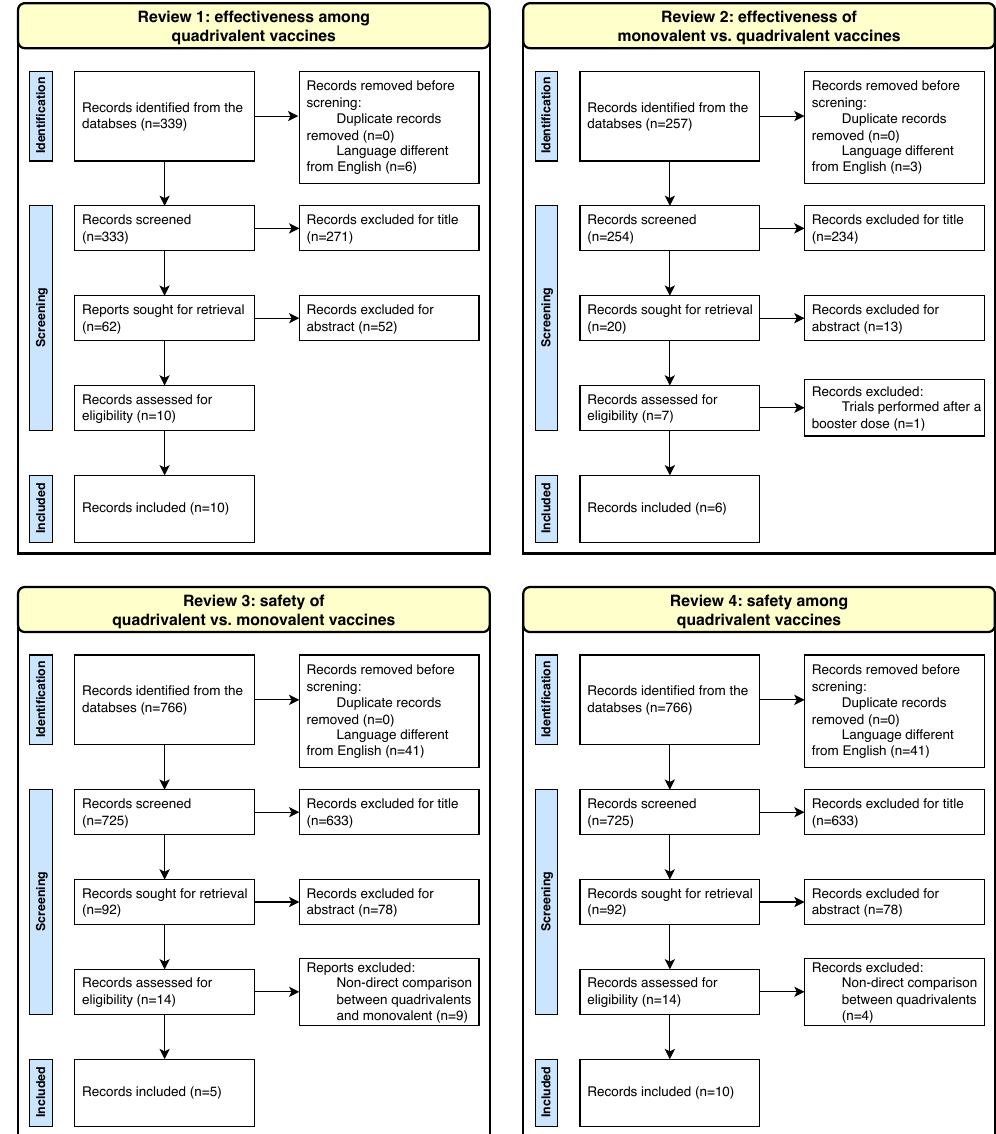
Figure A1. Prisma flowcharts of the four